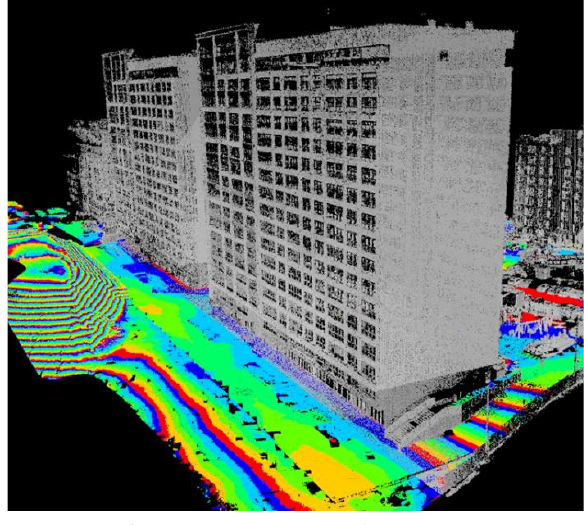
Figure 7 . 3D point cloud of the